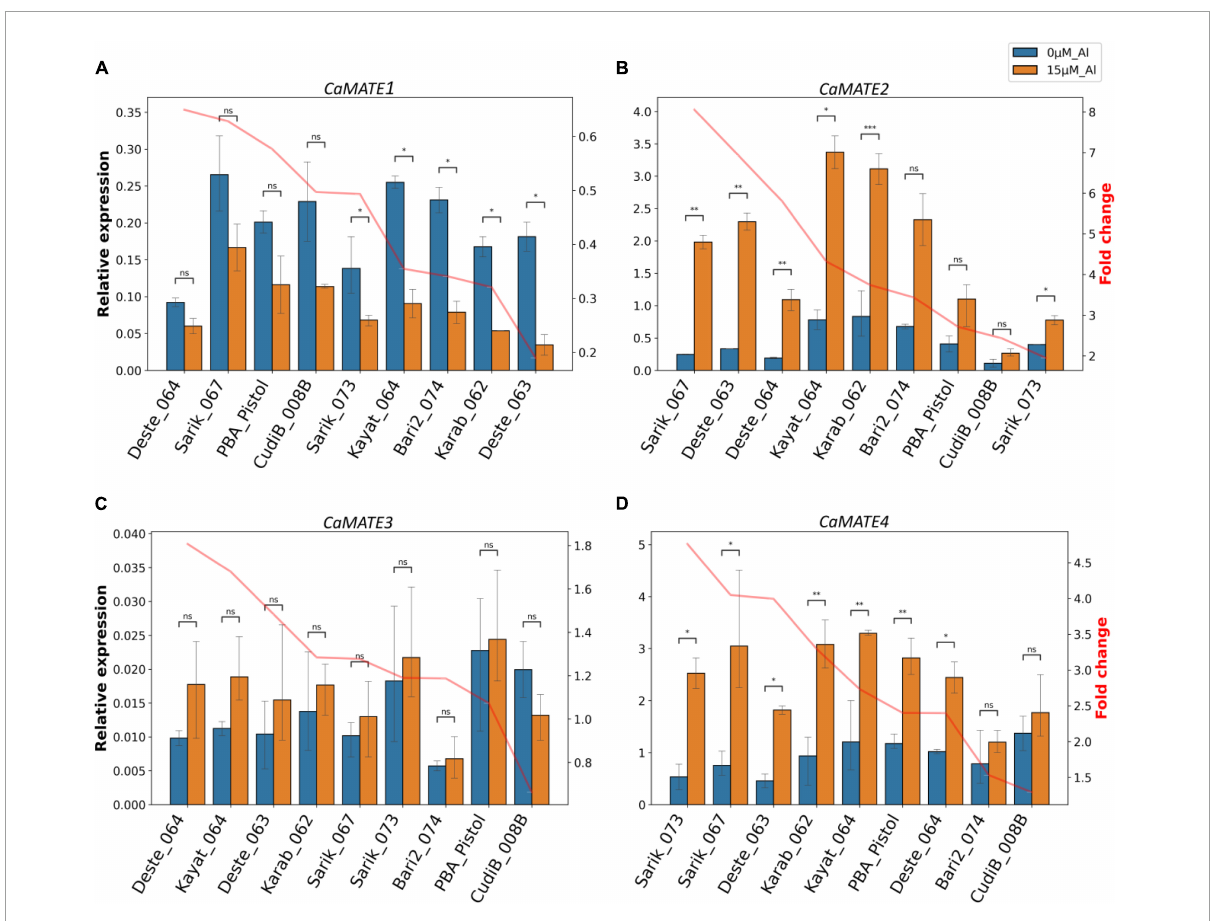
FIGURE5 qRT-PCR analyses of chickpea MATE genes in root tips. The relative transcription of CaMATE1 (A) , CaMATE2 (B) , CaMATE3 (C) , and CaMATE4 (D) were determined in nine chickpea accessions at 0 and 15 µ M Al 3 + after 2 days of hydroponic cultivation. The previously determined CaCAC was used as the reference gene (Reddy et al., 2016). Transcription fold change (FC, in orange) at Al treatment condition compared to control was calculated. The plotting was sorted by FC from highest to lowest. *1.00e-02 < p < 5.00e-02, **1.00e-03 < p < 1.00e-02, ***1.00e-04 < p < 1.00e-03, n.s